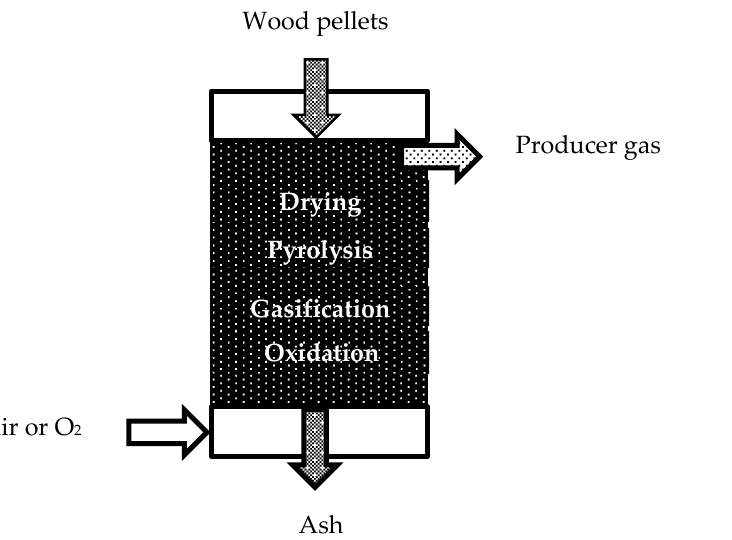
Figure 2. Schematic diagram of an updraft gasifier with flow patterns for gases and solids.